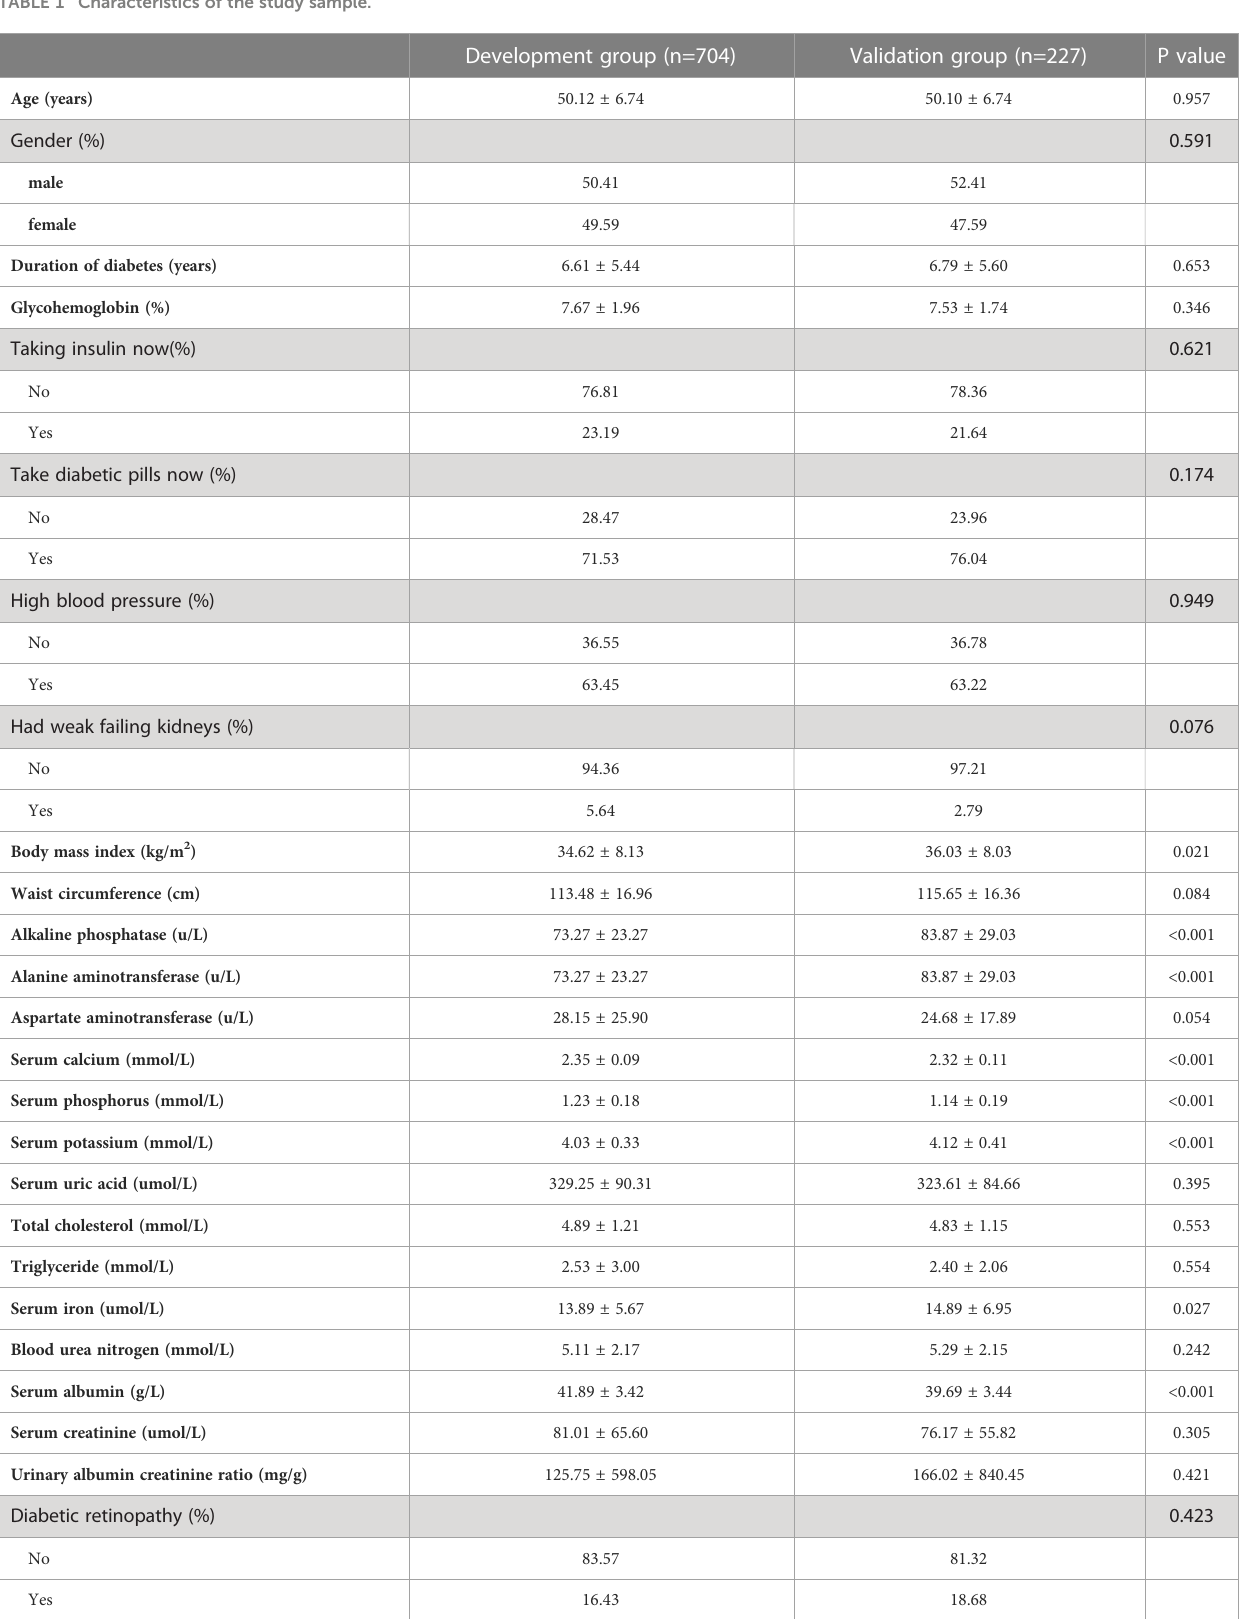
TABLE 1 Characteristics of the study